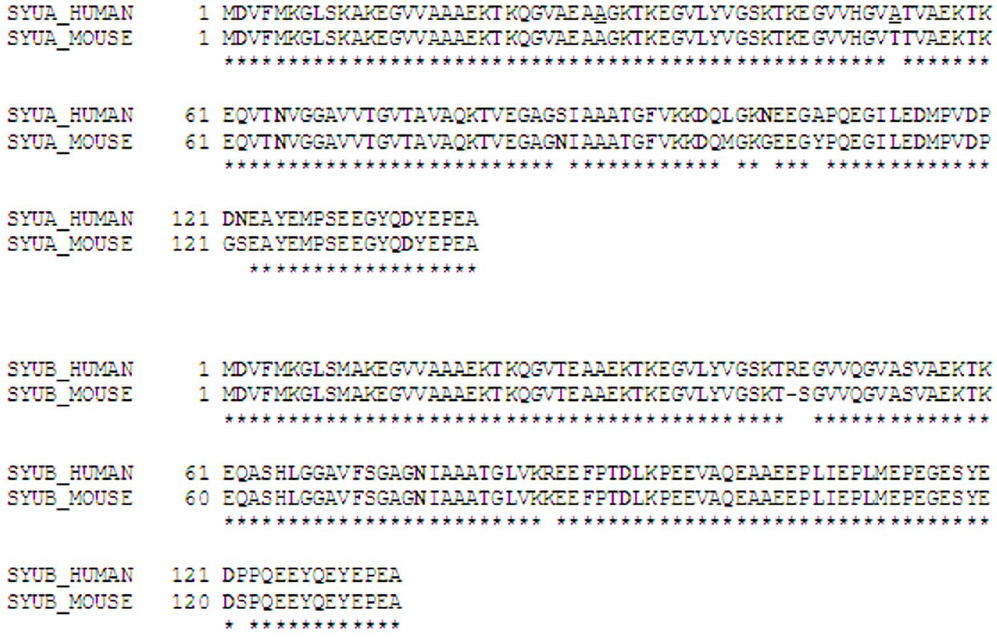
Figure 2. Amino acid sequence alignment of human and mouse a -synuclein, and human and mouse b -synuclein. Identical amino acids are marked with an asterisk. The positions of the human a -synuclein familial mutants A30P and A53T are underlined. Aspartic acid and asparagine residues that may give rise to isoaspartate formation are shown in bold.